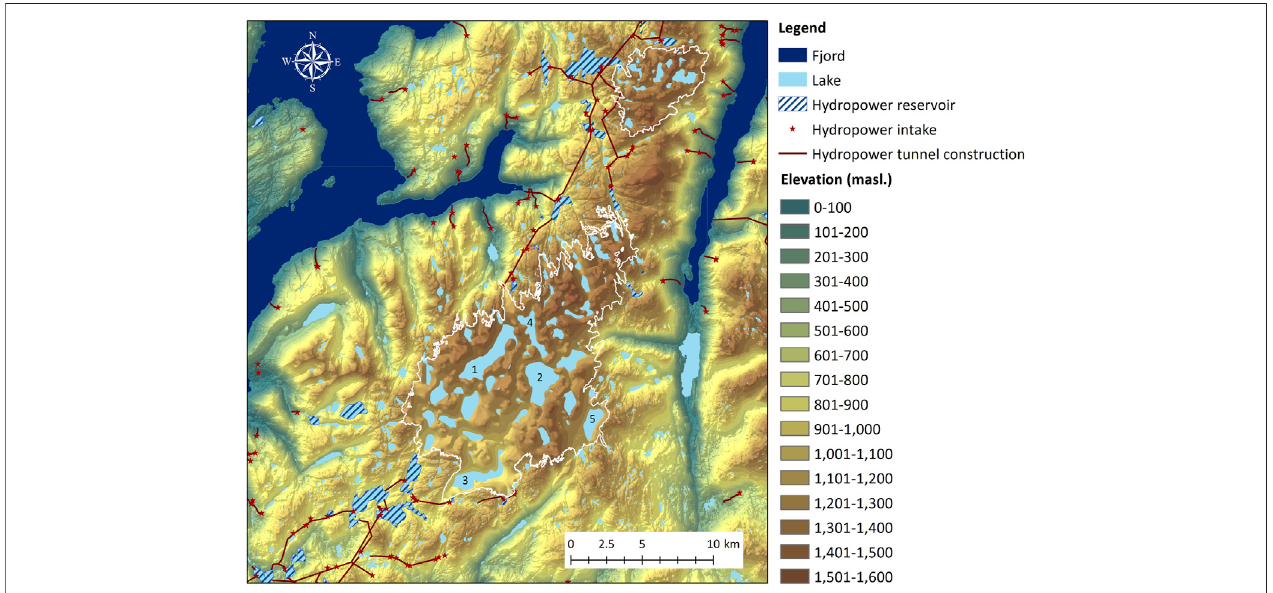
FIGURE 7 | Subglacial bed topography and future possible lakes (light blue). Hydropower constructions are marked in red and current reservoir lakes are marked withdarkbluestripes.Theelevationabovesealevelismarkedbycolor.The fi velargestfutureforminglakesoftheSørfonnalandscapearemarkedbyanumber(seetheir parameters in Table 2 ).